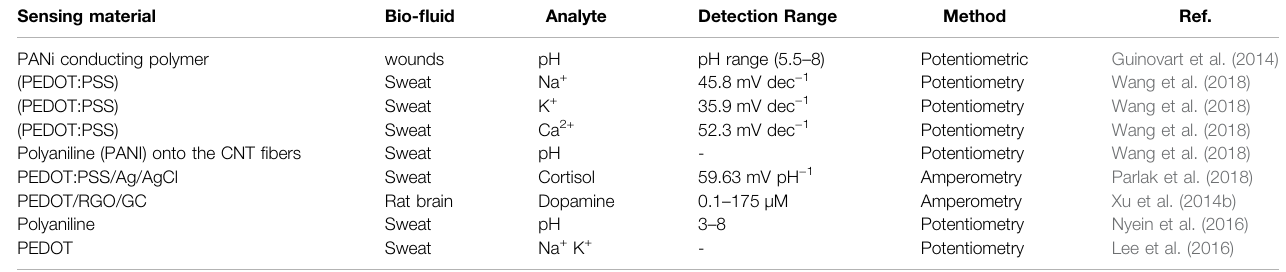
TABLE 4 | Conductive polymer nanomaterials in electrochemical biosensors. Sensing material